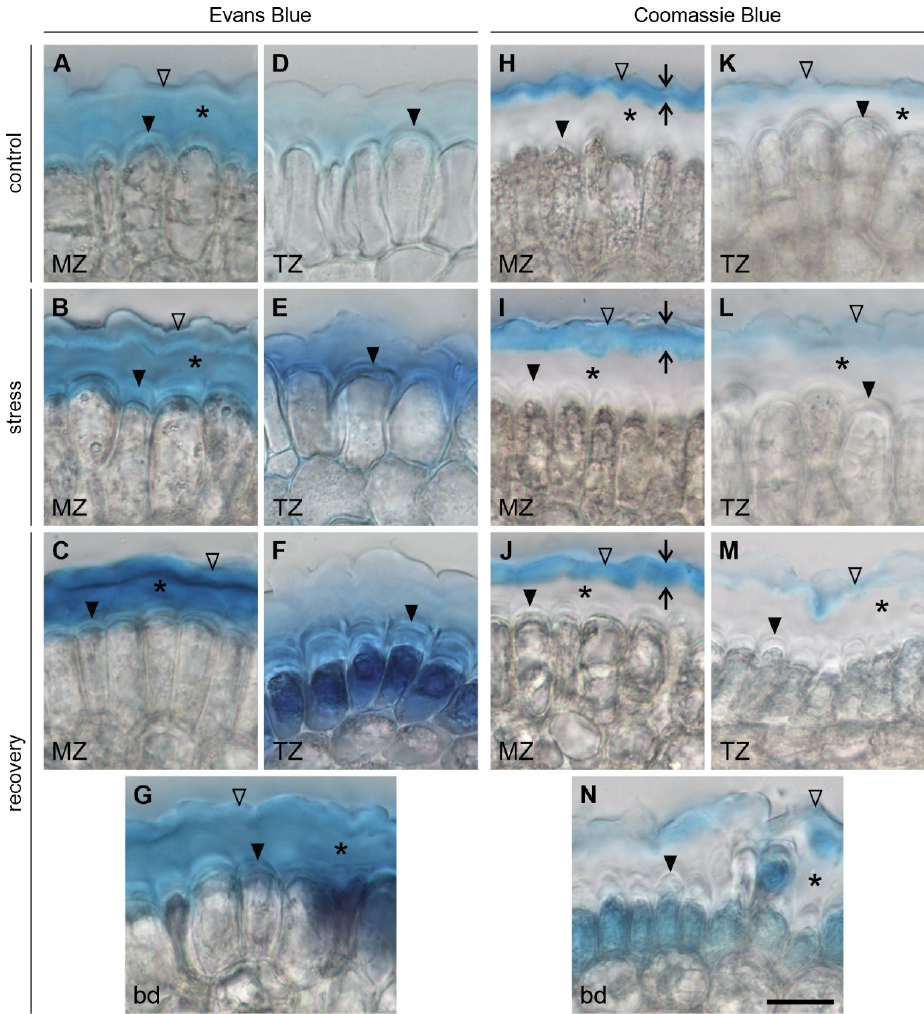
Figure 7. Cross sections of the roots stained with Evans Blue ( A – G ) and Coomassie blue ( H – N ). Cut at the level of 1 mm from the root/cap junction (meristematic zone) in C, S and R roots ( A – C , H – J ), at the level of 2 mm from the root/cap junction (transition zone, D – F , K – M ) and at the boundary between differentially stained regions in R roots ( G , N ). Short arrows in ( H – J ) show the L3 thickness. Solid arrowheads, asterisks and empty arrowheads indicate the L1, L2 and L3, respectively. MZ meristematic zone, TZ transition zone, bd boundary between differentially stained regions in R roots. Scale bar ( N ) referring to all images: 20 μm.